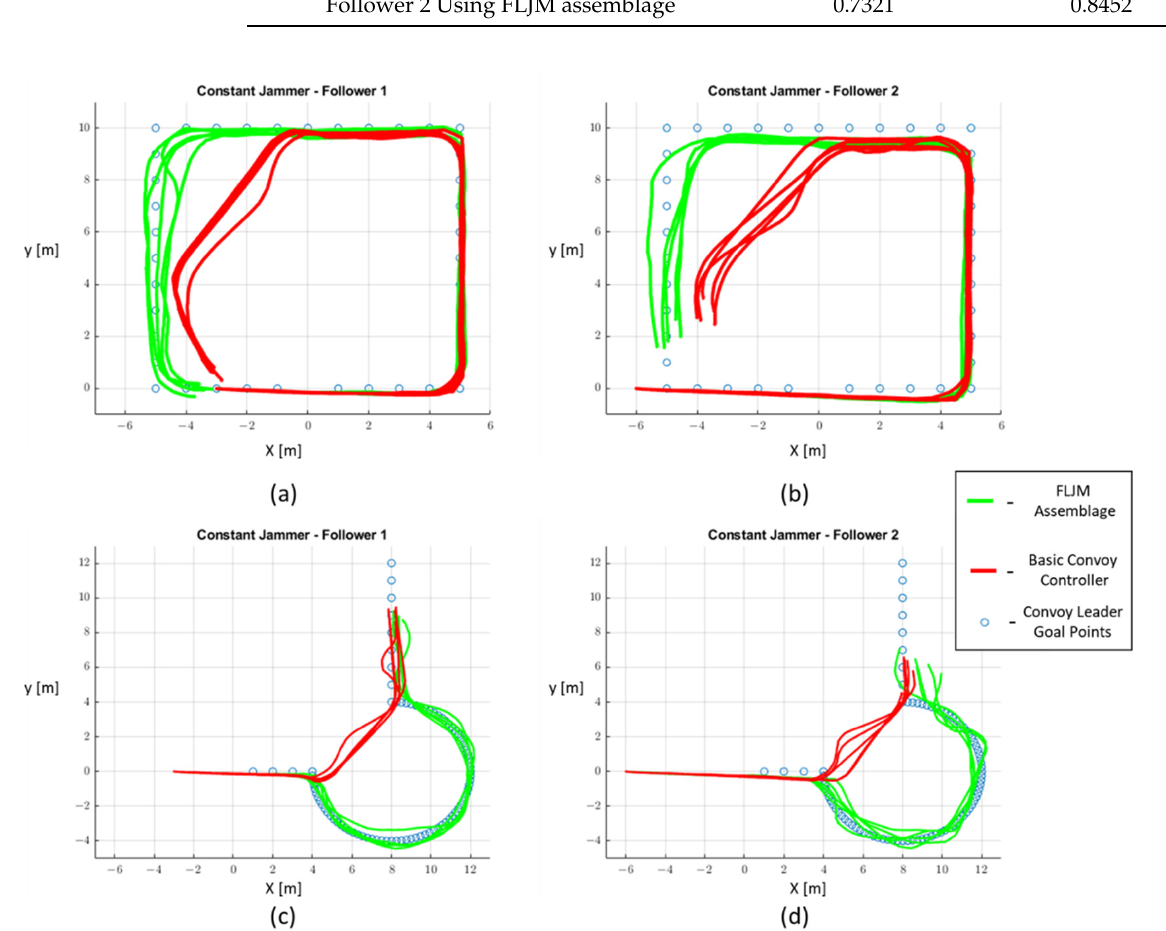
Figure 17. Plot of the paths taken by the followers under constant jamming on the square path for ( a ) follower 1 and ( b ) follower 2; and on the roundabout path for ( c ) follower 1 and ( d ) follower 2.